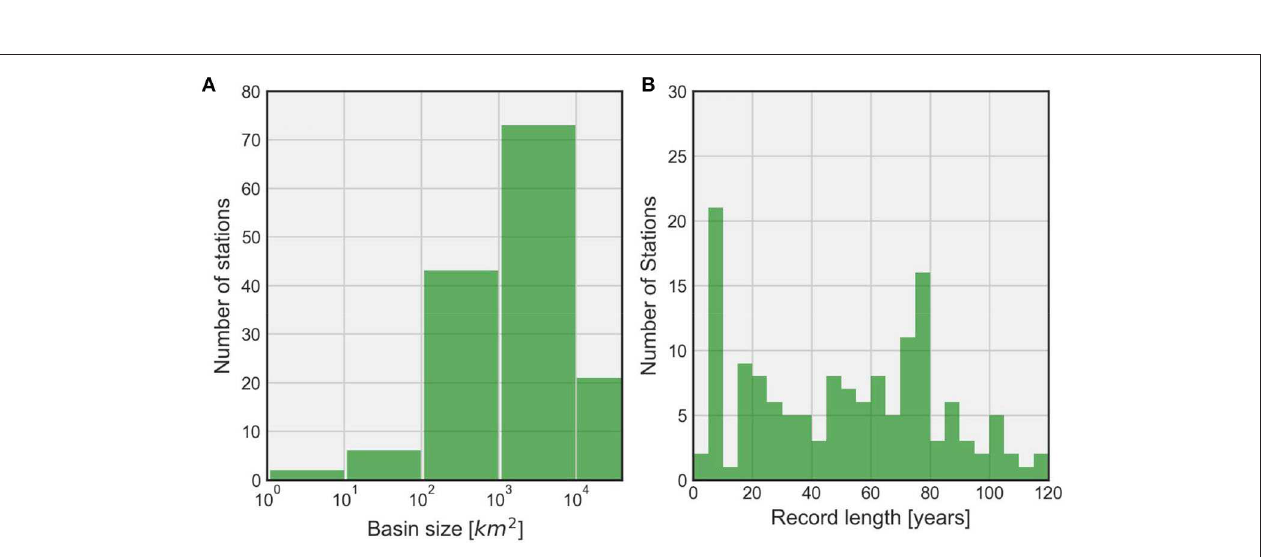
Frontiers in Water |